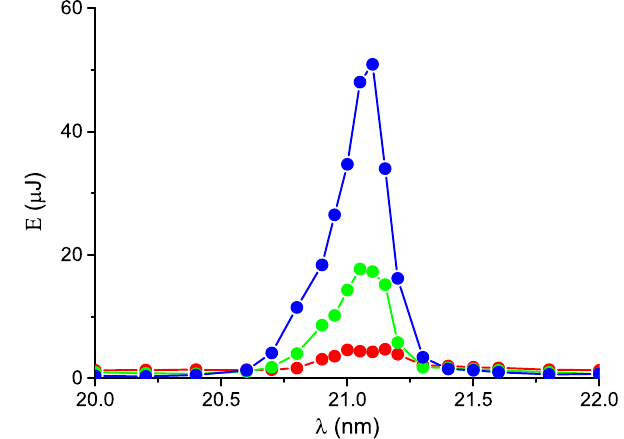
FIG. 4. Scan of the resonance wavelength of the first part of the undulator consisting of one undulator section (red), two sections (green), and three sections (blue). Pulse energy is measured after the second part of the undulator tuned to 7